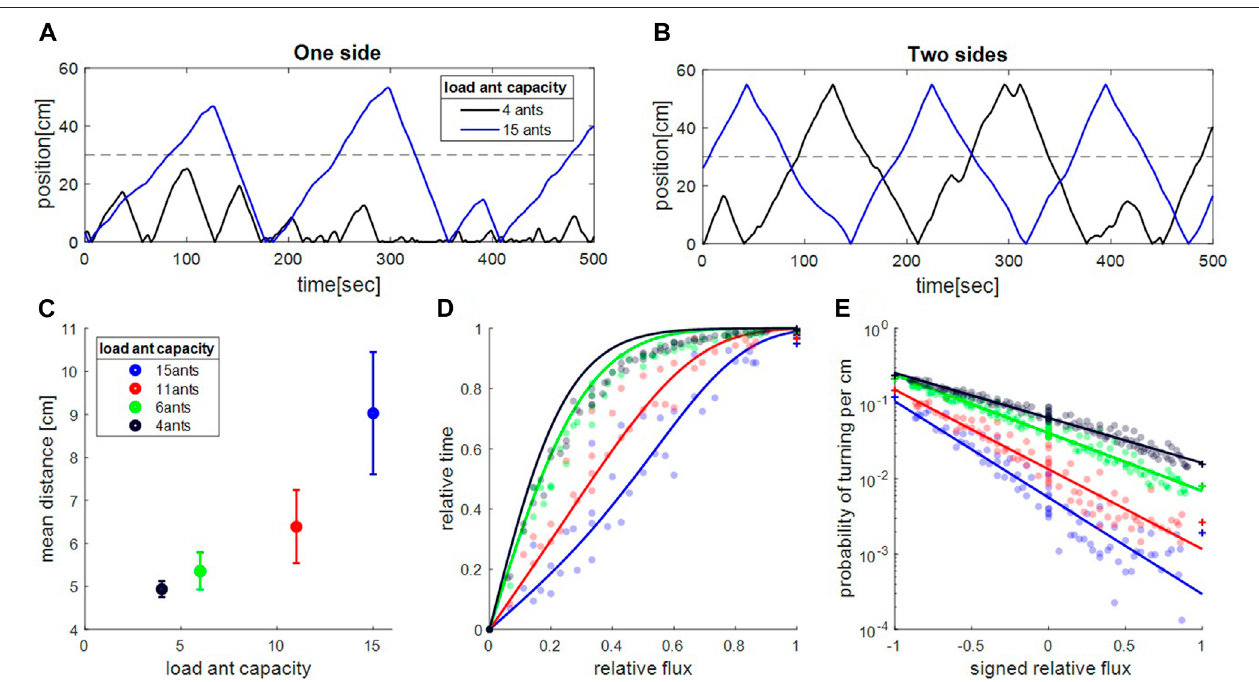
FIGURE 4 | Microscopic model captures empirical properties of motion. (A – B) . Simulated sample trajectories for one exit (A) and two exit (B) trajectories and two loadsizes(4and15ants).Thesearequalitativelycomparabletotheexperimentaltrajectoriesshownin Figures1A2 – D2 . (C) .Meandistancetraveledtowardclosedside in one side experiments. Data points were calculated assuming mean ant occupancy values that coincide with those measured in the one-side experiments ( Supplementary Figure S11 ). Error-bars represent standard error of the mean over, from largest object to the smallest one, N (cid:1) 11 , 5 , 7 and eight independent runs of the simulation (each on the order of hundreds of hours). These results can be compared to the experimental results shown in Figures 2A (D) . Simulated relative time(see Supplementary Equation S56 ),with d (cid:1) 10 [ cm ] and L (cid:1) 55 [ cm ] ) spent nearthe twoexits functionofthe relative fl ux, f rel .Full lines arethe theoretical curves calculated with the use of the exponential fi ts of the probabilities of turning ( λ ) as a function of f rel ( Figure 4E , Supplementary Equation S58 ), assuming a run-and- tumblemodel(see SupplementaryEquationS59 ).Comparetotheexperimentalresultsshownin Figures2B(E) .Simulatedturningprobabilitypercm, λ ,asafunction of the signed relative fl ux f rel . Full lines represent an exponential fi t to the data (linear when plotted on a logarithmic scale, Supplementary Equation S58 ), with a larger slope for larger loads. The points at the ends ( f rel (cid:1) ± 1) represent averaged turning probabilities from one side experiments.